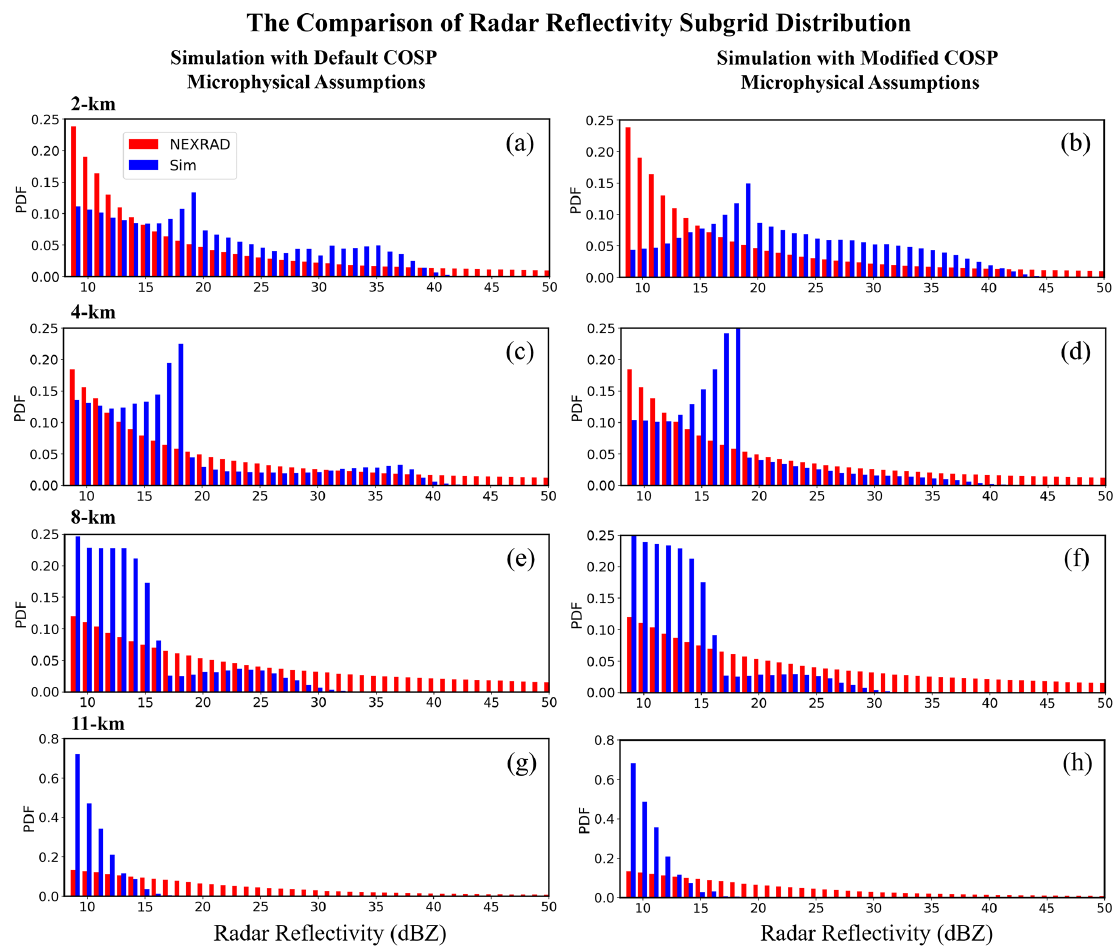
Figure 3. Comparison of radar reflectivity subgrid distribution between NEXRAD observations (red bars) and the simulations (blue bars) at the vertical levels of 2, 4, 8, and 11km. Simulation results in the left and right columns are from the default microphysics assumptions in COSP and modified COSP microphysics assumptions,